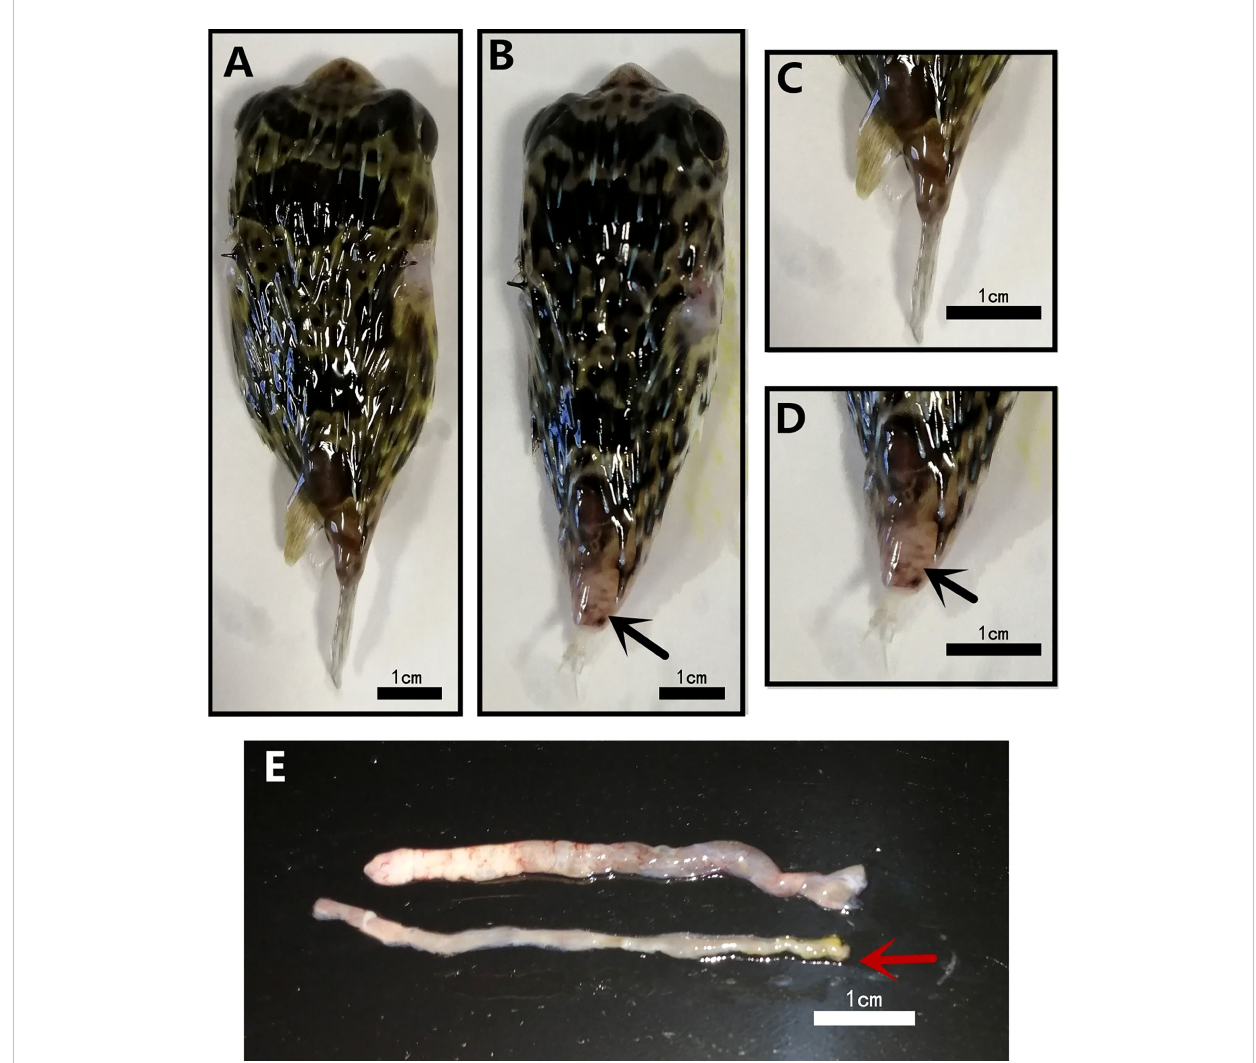
FIGURE 1 Morphological differences in normal (NOR) and tails fell syndrome (TFS) Diodon hystrix . (A) healthy D. hystrix. (B) TFS D. hystrix. (C) Closeup of the tail of health D. hystrix. (D) Closeup of the tail of TFS D. hystrix , the black arrows indicate the festering and broken tails. (E) The state of the intestines of health and TFS D. hystrix , the red arrows indicate the intestines of TFS D. hystrix